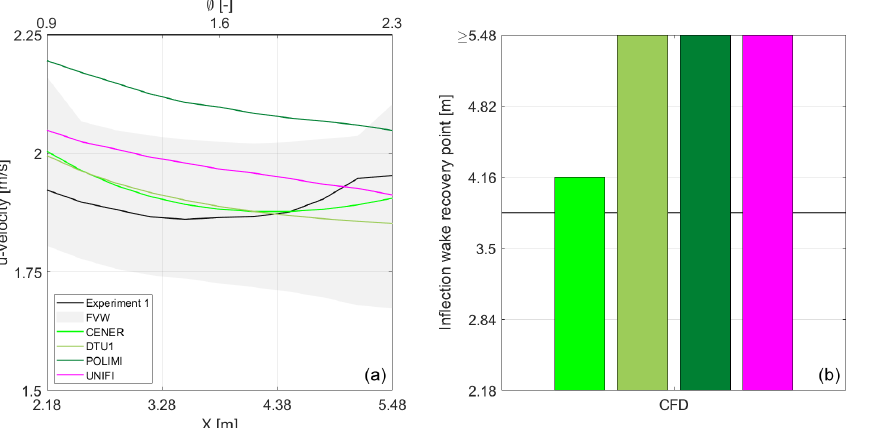
Figure 7. (a) Averaged hot-wire longitudinal velocity for one rotor revolution in the along-wind direction ( y = 0 . 9m, z = hub height) during steady wind conditions. (b) Inflection wake recovery point